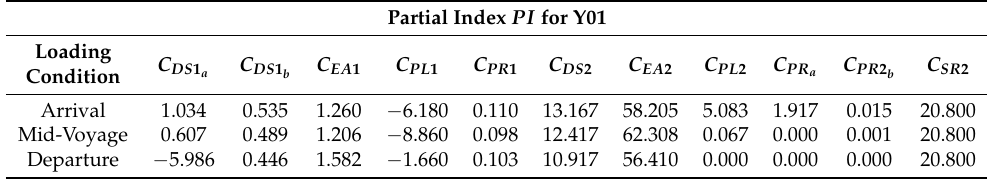
Table 6. Partial index, taking into account stability in waves performance of Y01. Values of si equal to or lower than 1.0 means the loading condition is compliant with the criterion.